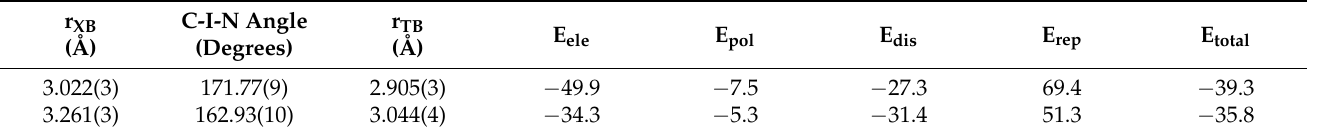
Figure 15. Crystal Explorer interaction energies (in kJ/mol) for the two halogen bonding interactions within cocrystal 2 • 3 . Table 4. C-I-N angles and interaction energies (in kJ/mol) between halogen bonded molecules in cocrystal 2 • 3 .